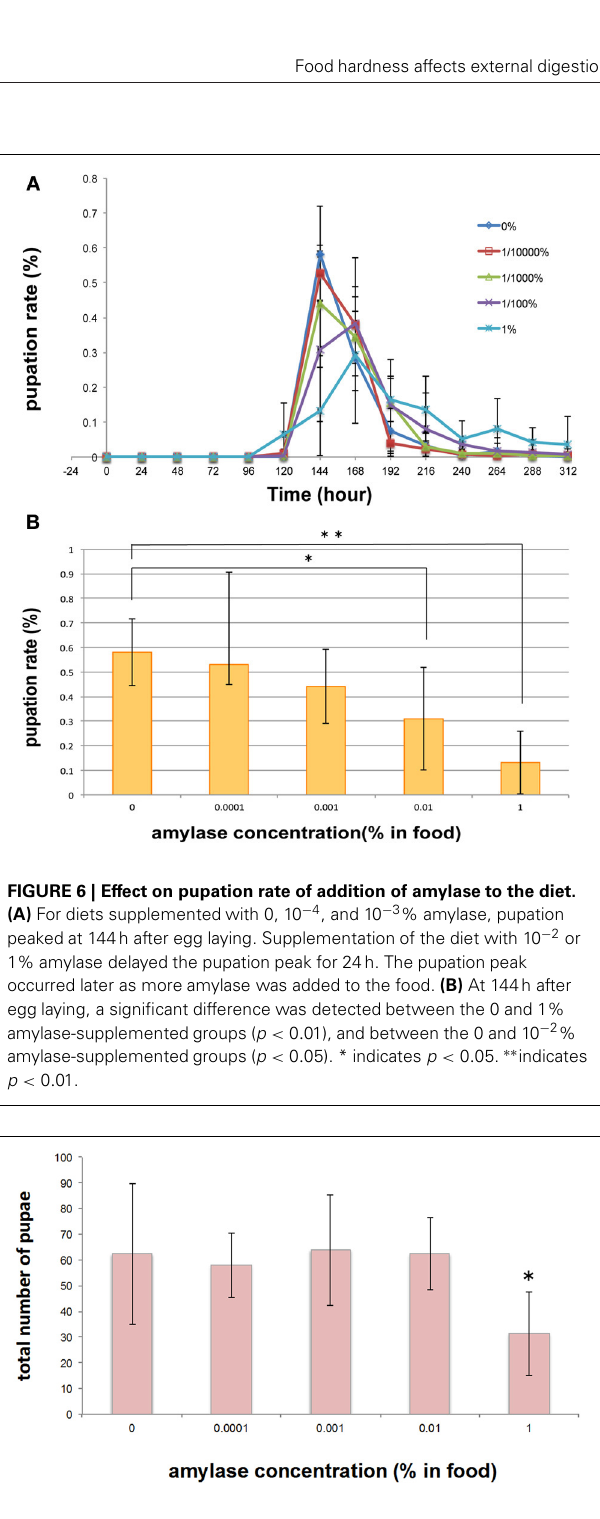
FIGURE 7 | Effect on the total number of pupae of addition of amylase to the diet. The total number of pupae did not differ significantly between the groups, except for the 1% amylase-treated group. ∗ indicates p < 0 .